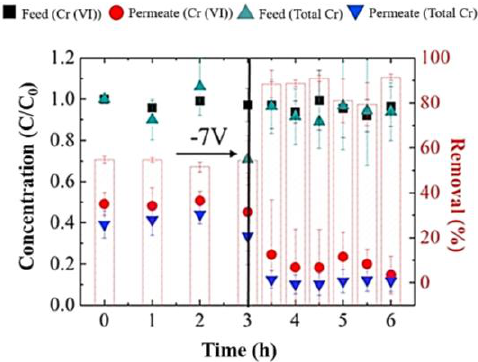
Figure 4. Removal of chromium from tap water spiked with 1 ppm Cr(VI) using a 6 µm-tick membrane. Reprinted from [89], with permission from Elsevier.